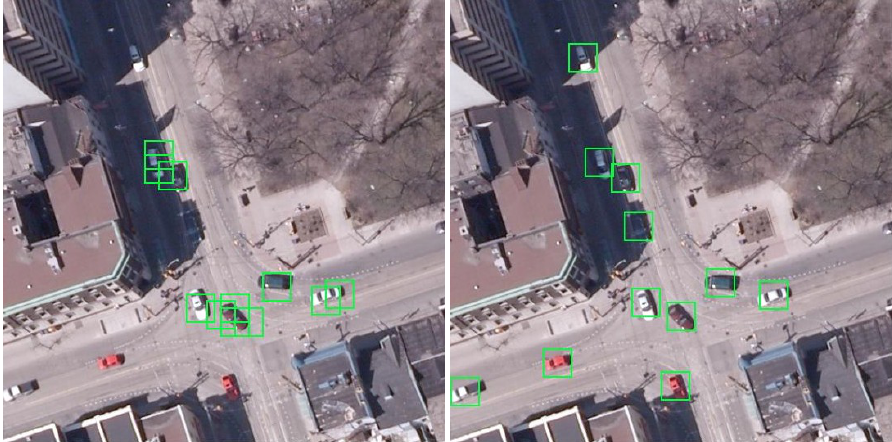
Figure 6. Predictions of RetinaNet on COWC when trained on noisy annotations ( left ) and corrected annotations ( right ). Best viewed in